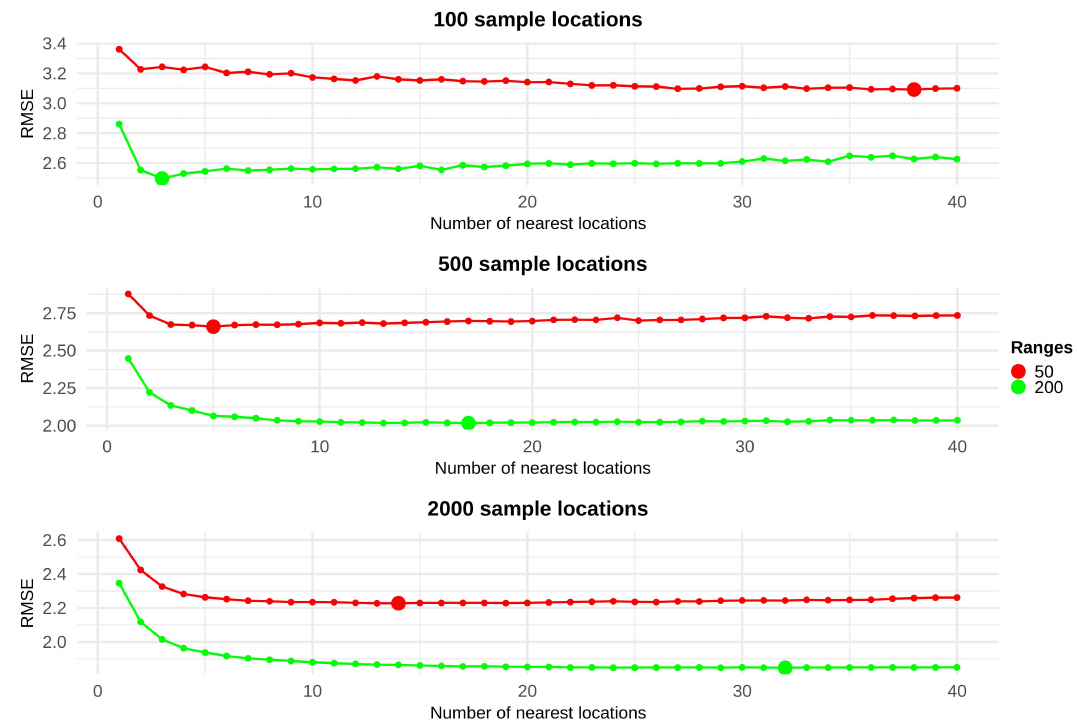
Figure 8. RMSE vs number of nearest locations ( n ) used in RFSI for one simulation with nugget-to-sill ratio 0.25, ranges 50 and 200, using 100 ( top ), 500 ( middle ) and 2000 ( bottom ) sample locations. Larger discs represent the optimal number of nearest locations with minimum